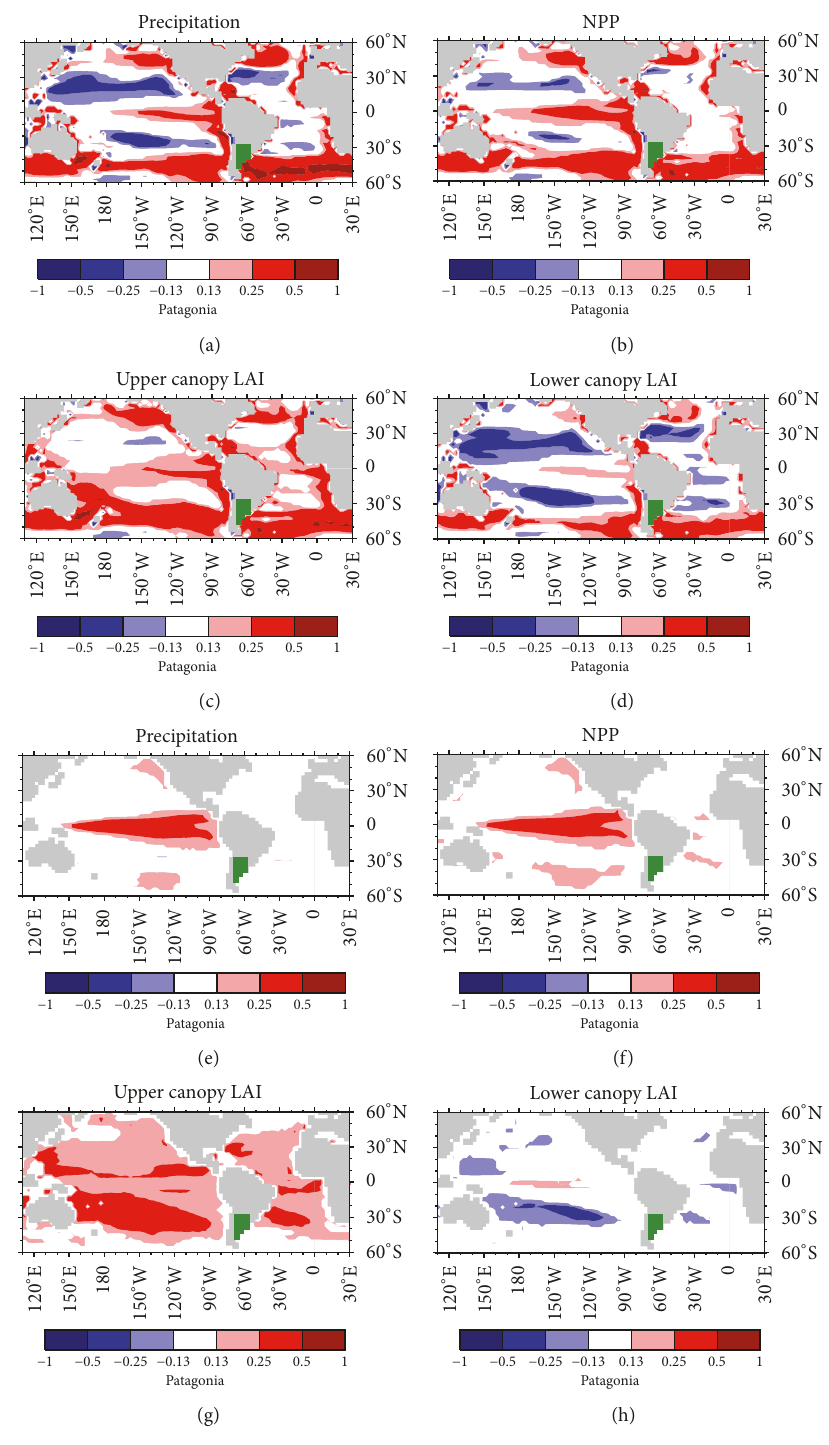
Figure 10: Same as Figure 5 but for PA